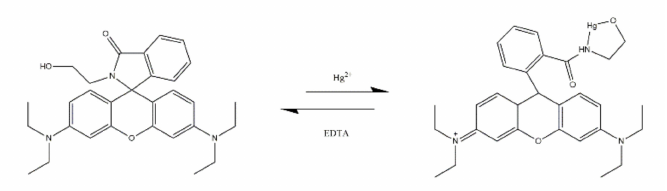
Figure 6. The possible mechanism of Probe 2 (Table 1, No. 7) to Hg 2+ [39]. A ferrocene-based rhodamine-hydrazone molecular probe (Table 1, No. 2) was synthe- sized using the solid-state synthetic method by Dewangan S., et al. [40]. The probe showed